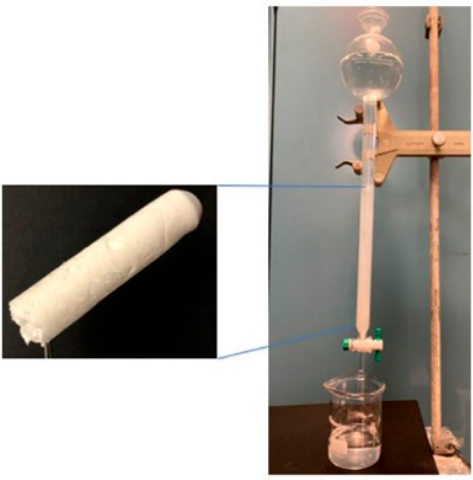
Figure 1. Freeze-dried NOCNF adsorbent and the adsorption column setup.